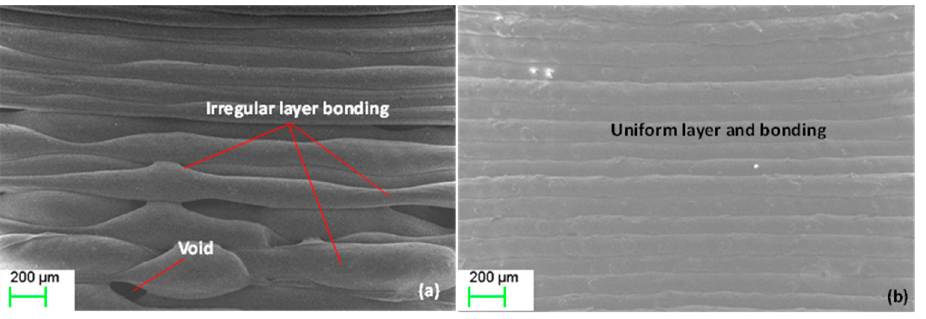
Figure 9. SEM imaging of the interfacing bonding between the layers for: ( a ) waste; ( b ) 4% Mg prints.